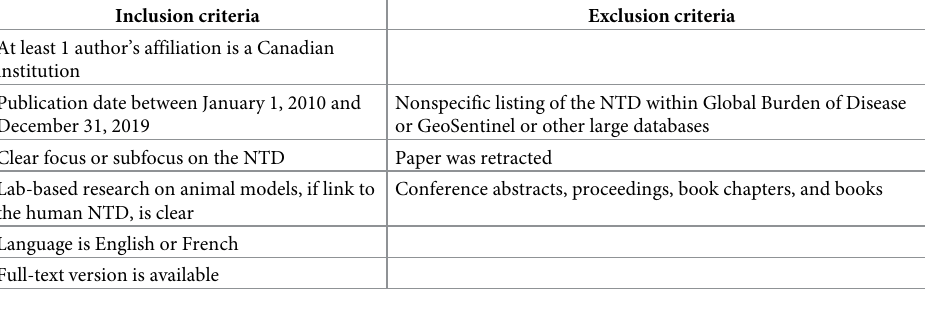
Table 1. Inclusion and exclusion criteria applied to each search in Scopus and Web of